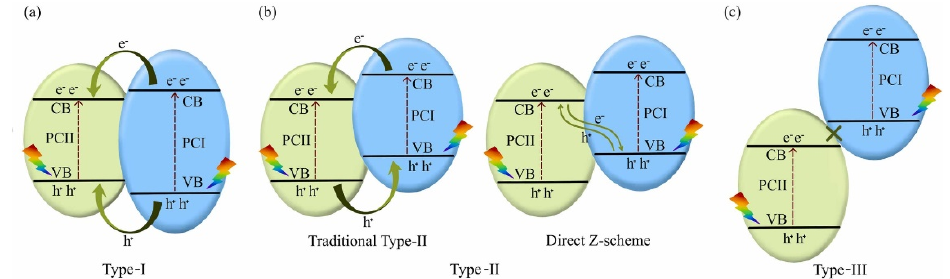
Figure 1. Different types of heterostructures: ( a ) type-I, ( b ) type-II, and ( c ) type-III heterojunctions. Reproduced from [30]. Copyright 2022, Elsevier.